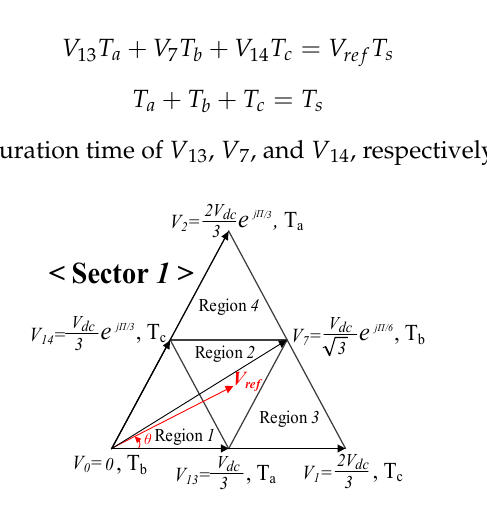
Figure 8. Sector 1 divided into four regions.